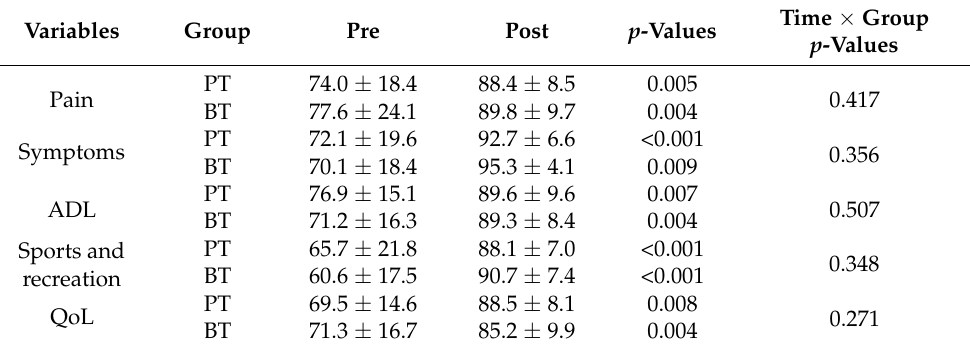
Table 6. Results of the Foot and Ankle Outcome Score for Pilates and balance training